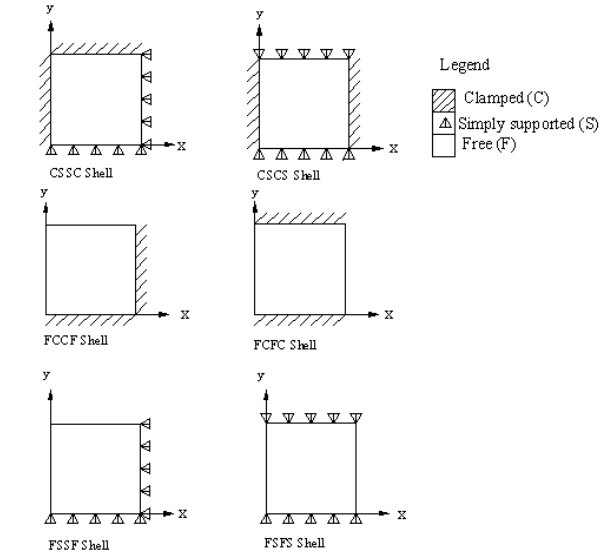
Figure 5: Arrangement of boundary conditions